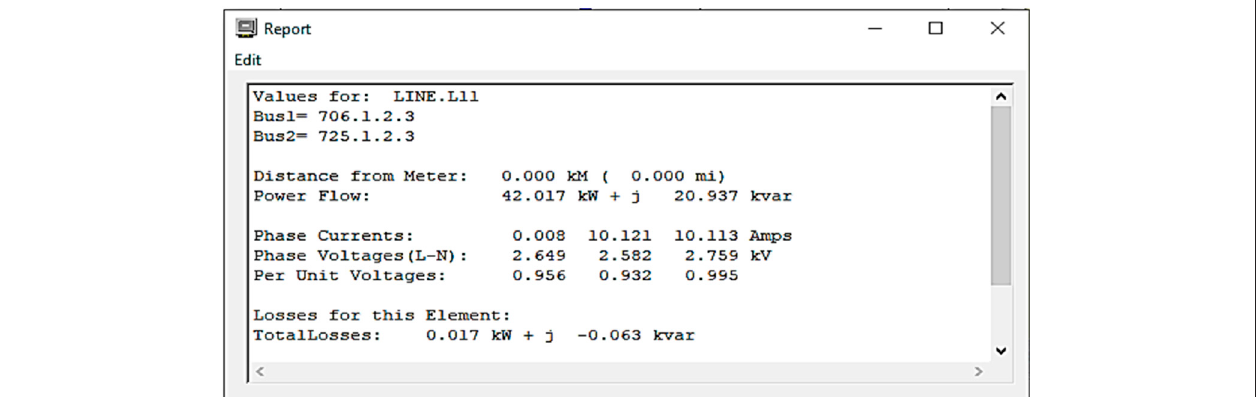
FIGURE 8 | Line.L11.